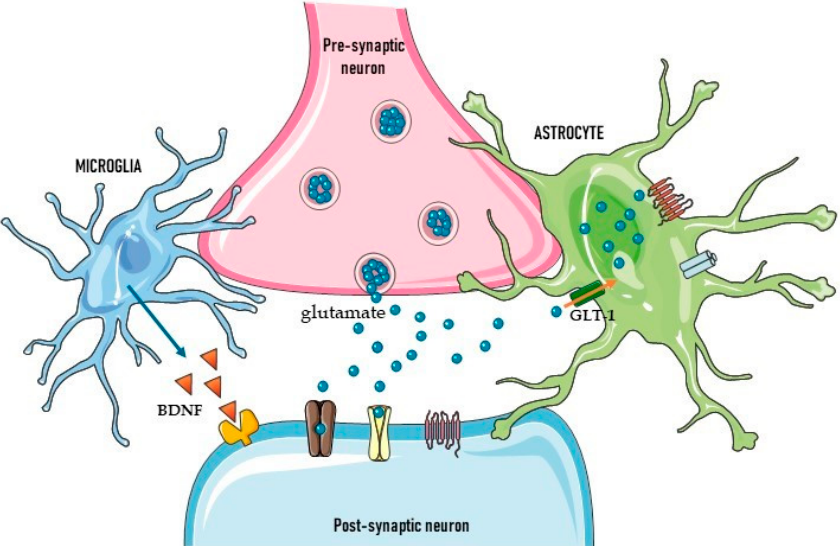
Figure 1. Scheme of a “quad-partite” glutamatergic synapse. The processing of information in synapses is not only defined by neurons, but also by astrocytes which enwrap and microglia that dynamically interact with synapses. Astrocytes respond to glutamate and other neurotransmitters such as GABA, noradrenaline, acetylcholine or ATP. Then astrocytic calcium waves can feedback to influence neuronal responses and control synaptic strength through the release of mediators such as glutamate, ATP, D-serine etc. Thus, astrocytes maintain glutamate homeostasis and the basal excitability of neurons. Microglia release soluble factors such as BDNF, TNF α , glycine, L-serine etc., which affect basal neurotransmission and synaptic plasticity (i.e., LTP) via direct action on neurons or indirectly via astrocytes.